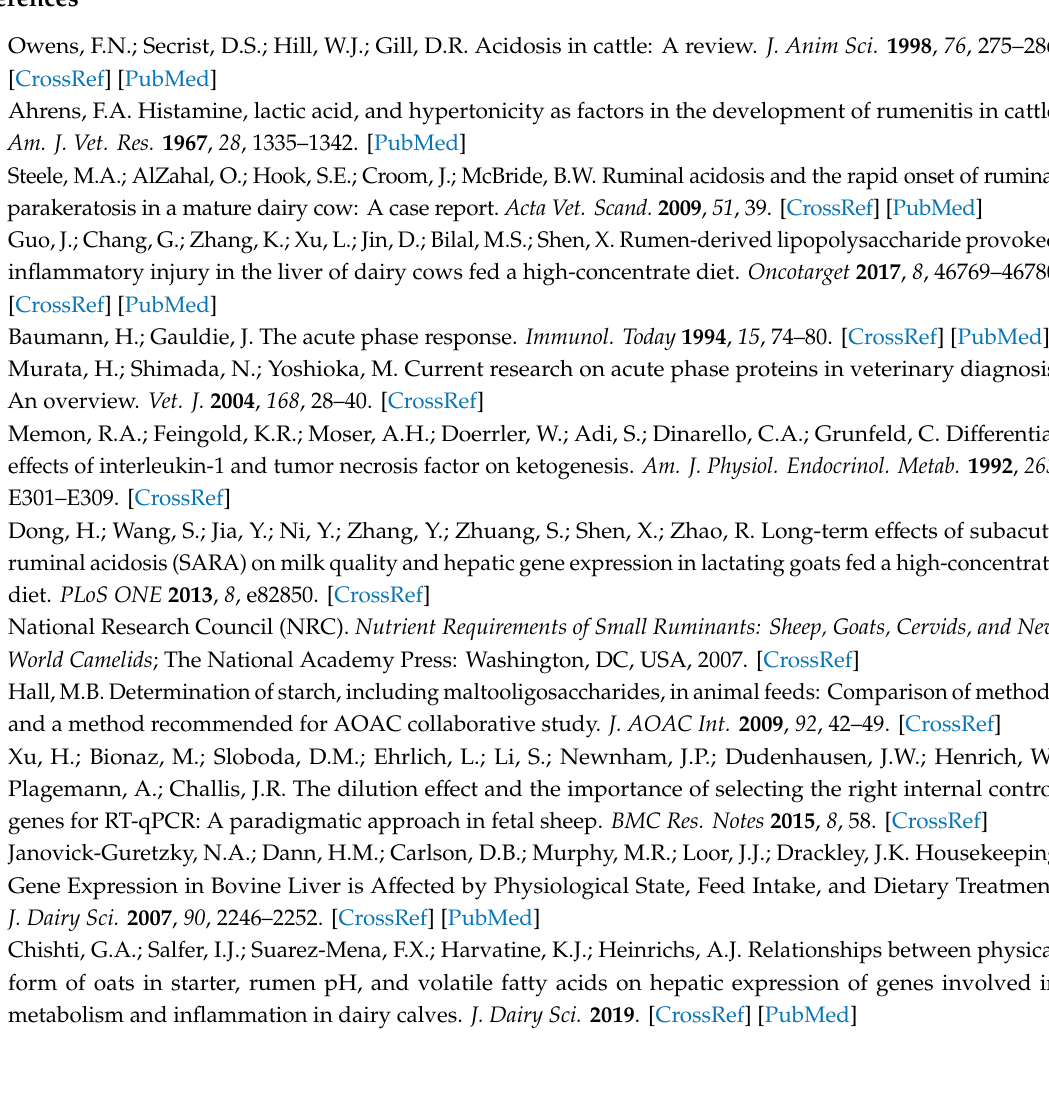
Table S1: Box-Cox transformation received by mRNA expression of genes used in this study, Table S2: Least square means ± SEM of mRNA expression of Serum α -amyloid and Haptoglobin before back